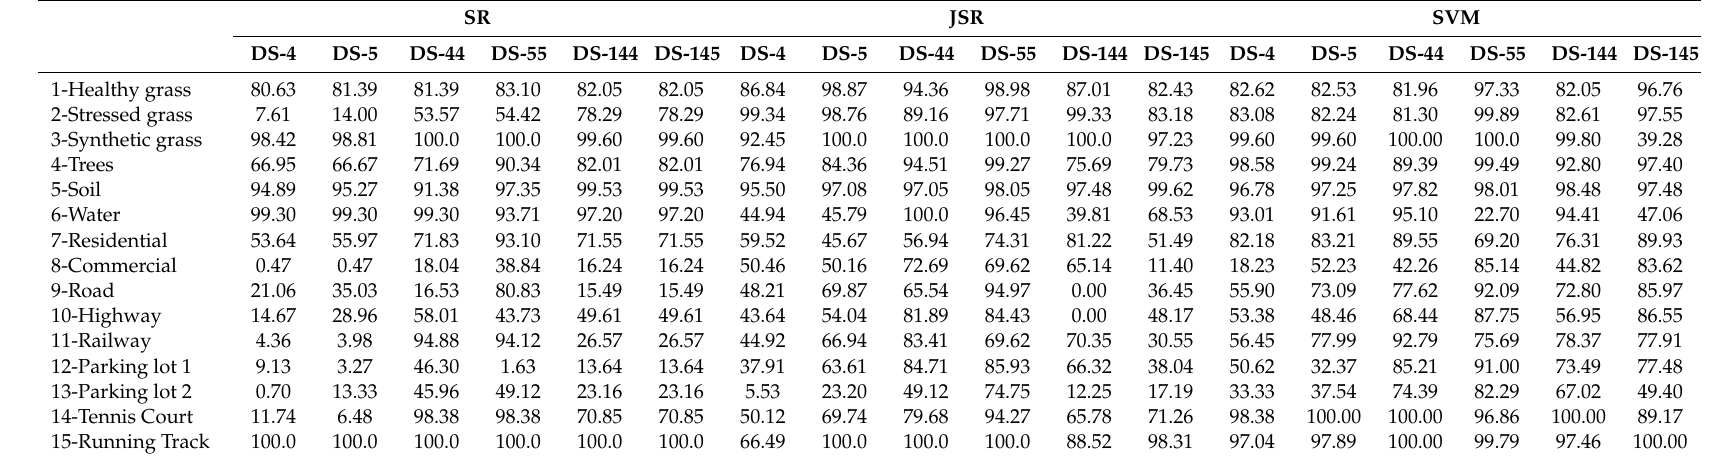
Table 8. Class specific accuracies of Sparse Representation (SR), Joint SR (JSR), and Support Vector Machine (SVM) with various band